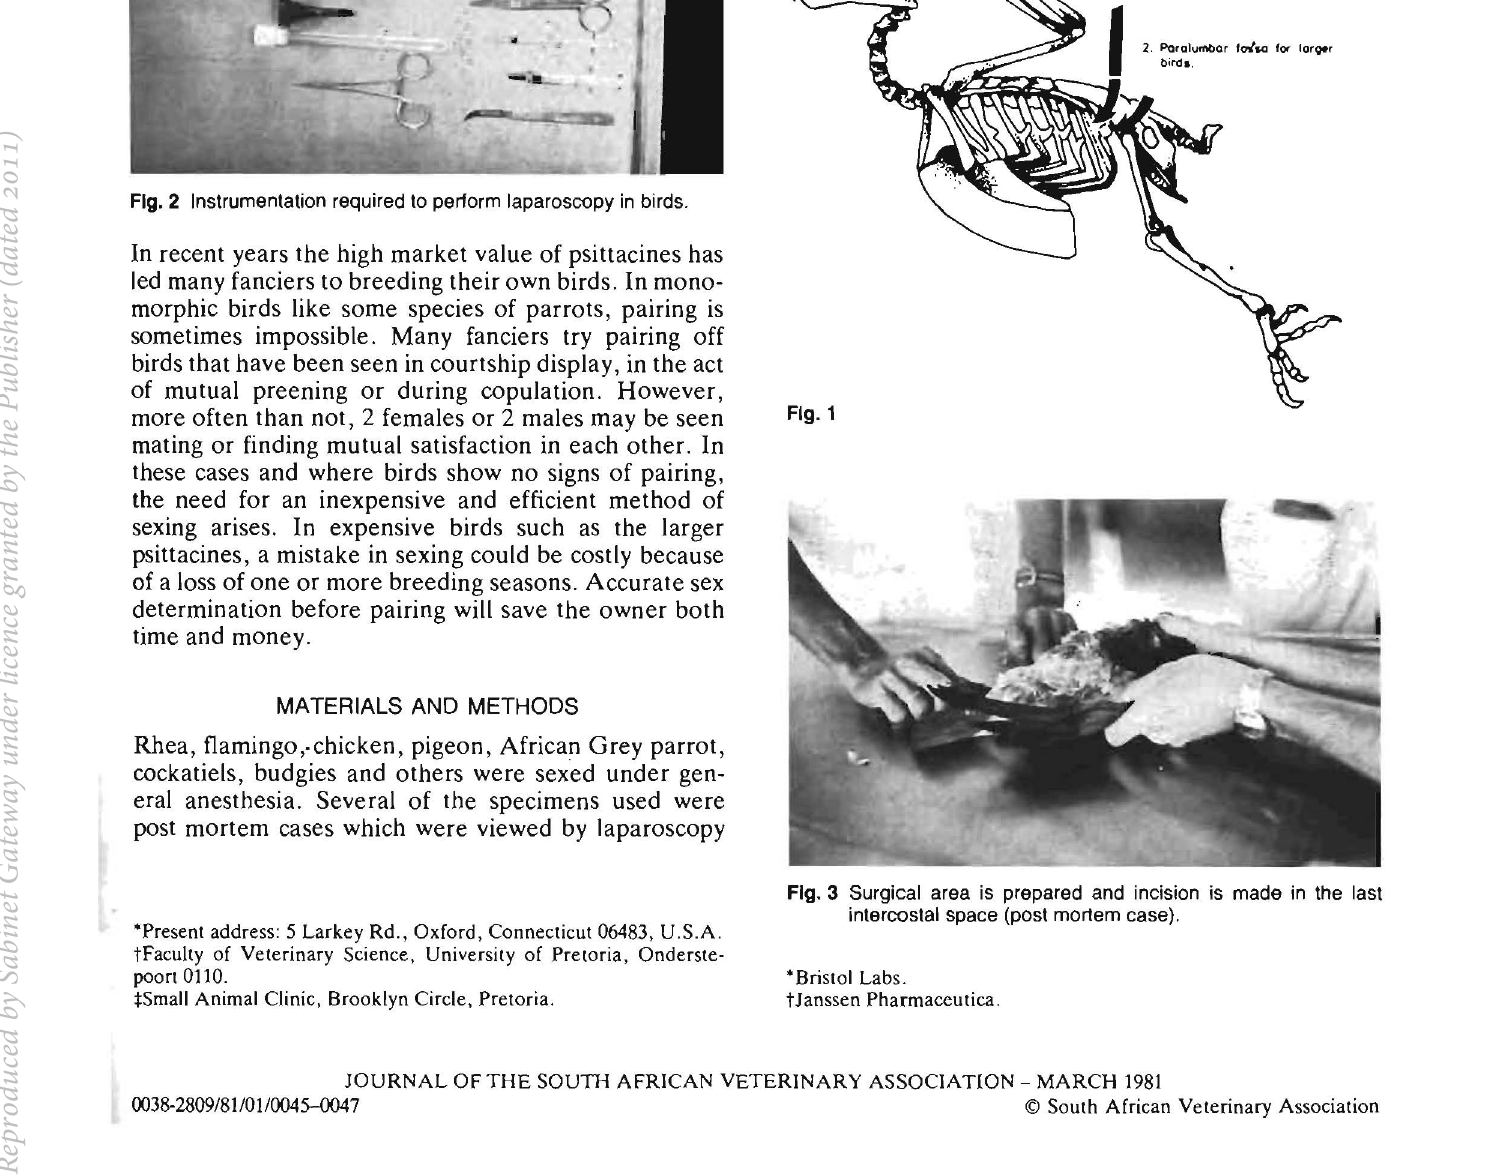
Fig. 3 Surgical area is prepared and incision is made in the last intercostal space (post mortem case). • Bristol Labs. tJanssen